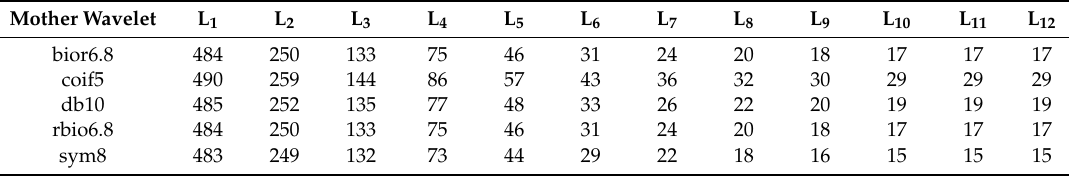
Table 4. The number of wavelet coe ffi cients under di ff erent mother wavelets and decomposition levels.